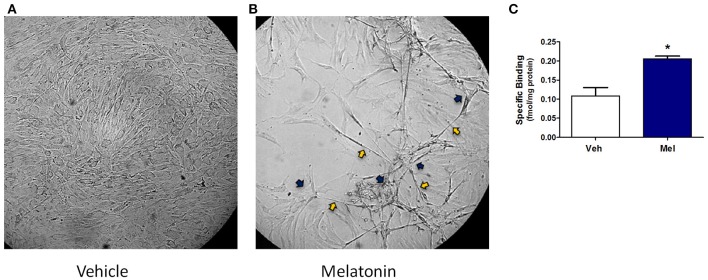
A non-diseased reduction mammoplasty explant (JL BRL-14) exposed to melatonin demonstrates accelerated pre-ductal differentiation. Preductal differentiation is manifested by the formation of double columns of elongated epithelial cells which are the precursors of tubular ducts that form spontaneously after 2–4 weeks in culture without trypsinization for this human breast explant. Photomicrographs of non-diseased JL BRL-14 explants after 5 h exposure to (A) vehicle (0.001% ethanol) and (B) 500 nM melatonin are shown (200x). The blue arrows point to cytonemes and the yellow arrows denote pre-ductal linearizations that form after 5 h in the melatonin-treated, but not vehicle-treated, BRL-14 cells. (C) Melatonin binding sites in JL BRL-14 explants were significantly higher after 28 h of treatment with 500 nM melatonin compared to the vehicle-exposed cells (*p < 0.05, unpaired t-test, n = 3).